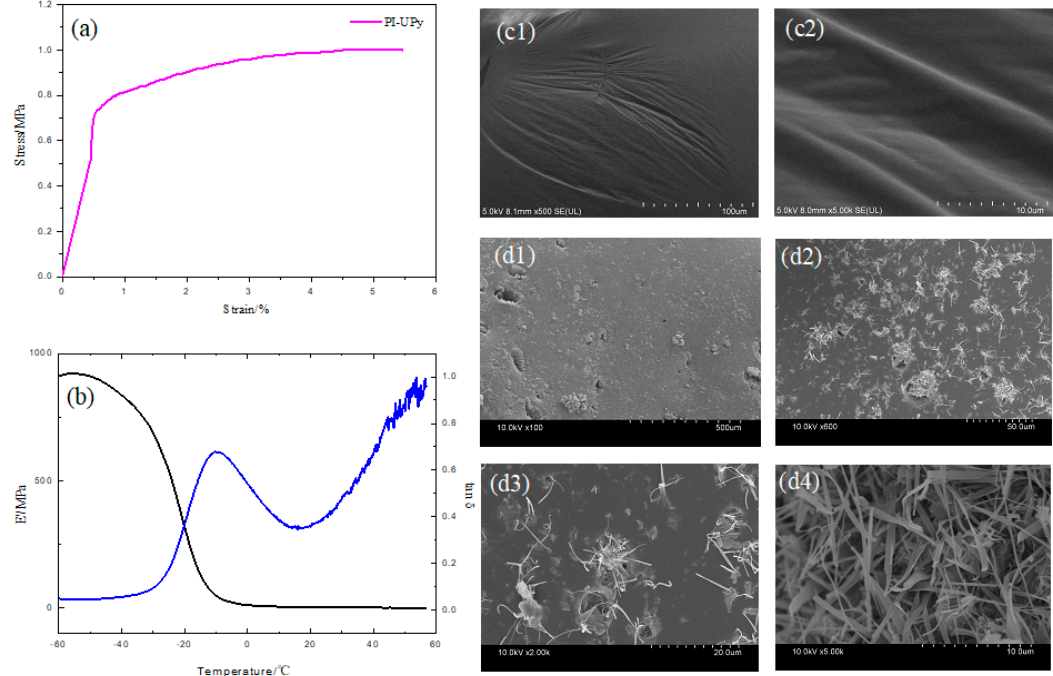
Figure 7. Mechanical behavior of PI-UPy: ( a ) stress–strain curves for PI-UPy; ( b ) E’ and tan δ ; SEM of ( c 1–2) PI-OH and ( d 1–4) PI-UPy.